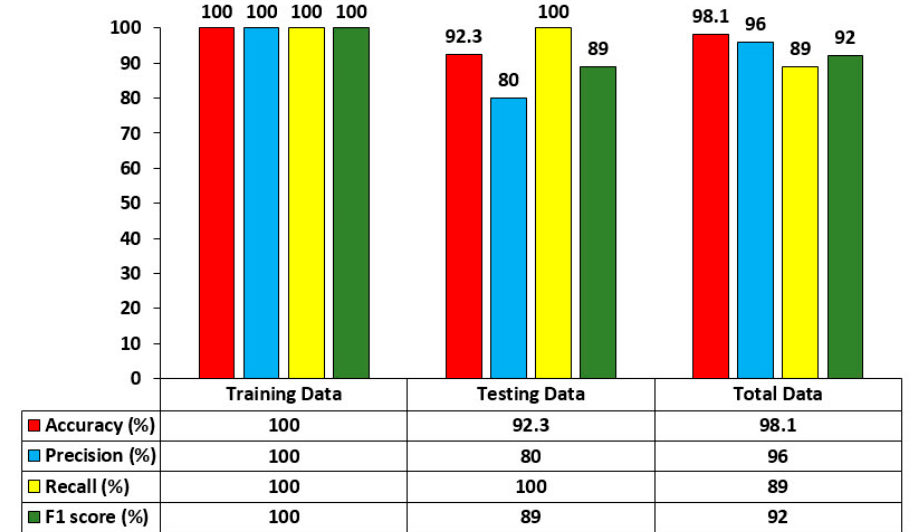
Figure 9. A comparison between the results of accuracy and other performance metrics.